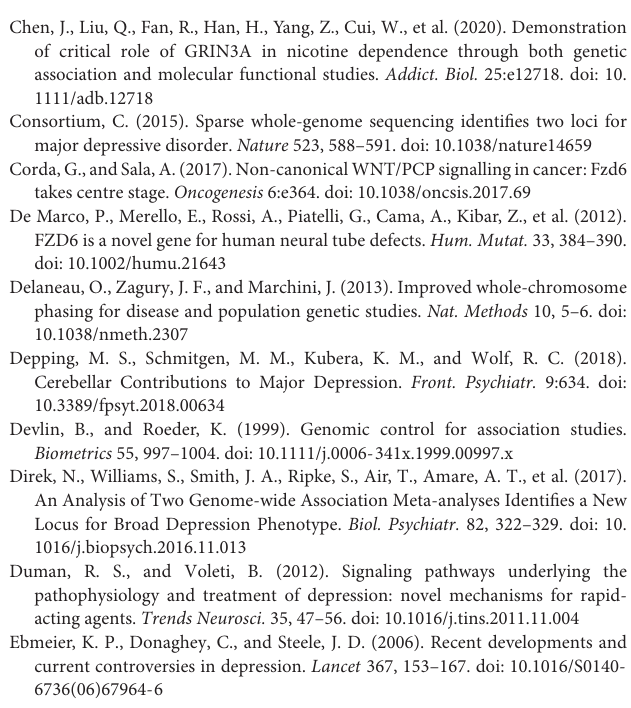
Supplementary Figure 1 | Generation of Fzd6-KI mice by CRISPR/Cas9 system. (A,B) Conservation analysis of rs61753730 (Q152E). (A) The UCSC Genome Browser Alignments depict nucleotide alignment of human FZD6 gene and homologs from other species. Position of rs61753730 variant is indicated by dashed red line. (B) Glutamine (Q) is conserved at same point in human, mouse, rat, and other animals. (C) Schematic of strategy for construction of Fzd6 point-mutation mice via the CRISPR/Cas9 system. The rs61753730 is located in fourth exon of Fzd6 . Red asterisk indicates mutation site. (D) Sequencing chromatogram to identify WT (with C allele) and Fzd6 -KI (with G allele) mice from tail genome DNA. Dashed red line marks location of rs61753730 in two types of